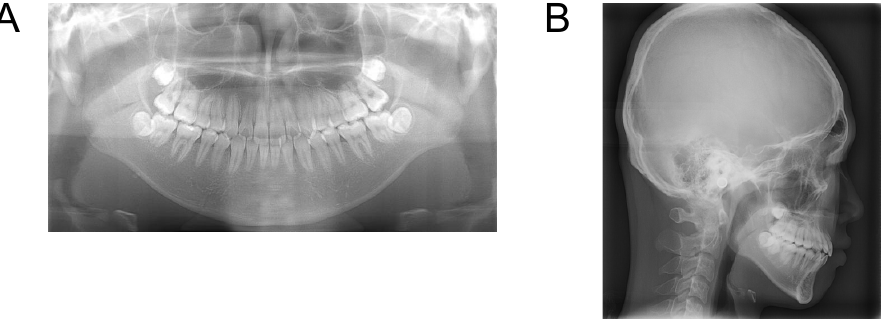
Figure 5. Facial photograph and intra-oral photograph of Case 1 at the end of the first stage of treatment; facial photograph and enlarged photograph of the mouth at the end of the first stage of treatment ( A ); intra-oral photograph at the end of the first stage of treatment ( B ).